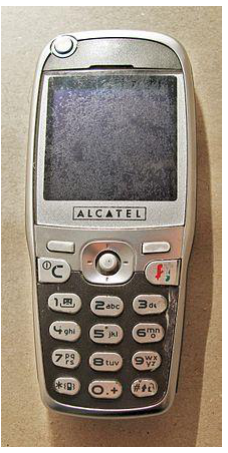
Figure 6. Alcatel One Touch 535 with Ni/MH battery [79].